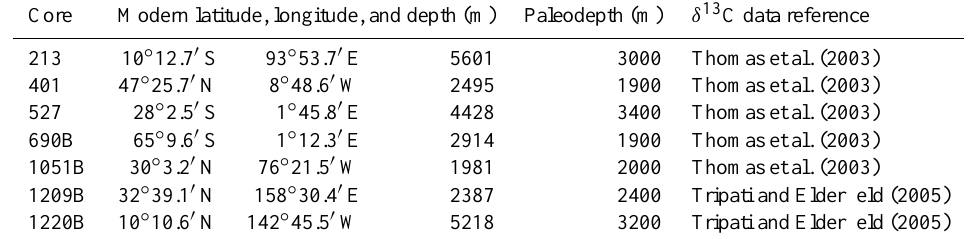
Table 1. Core information; all cores were collected as part of the Deep Sea Drilling Program (DSDP) and the Ocean Drilling Program (ODP). Core